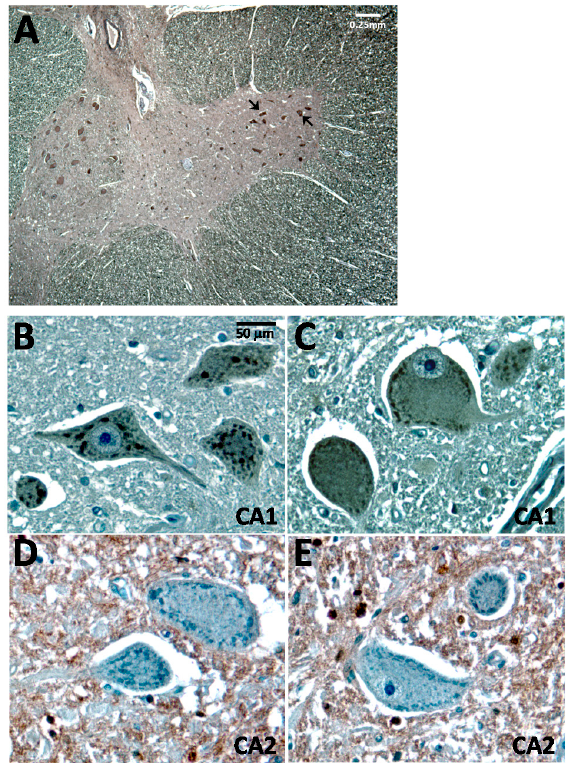
Figure 1. CA1 is expressed in human spinal cord motor neurons. Images of the normal human spinal cord immune-stained with CA1 or CA2 antibody using the DAB method (brown color) counter-stained with hematoxylin (blue color). The G α CA1 (1:500) and HRP-Rb α CA2 (1:500) antibodies were used for this experiment. ( A ) A low magnification image of the ventral horn of spinal cord stained with the CA1 antibody. Two representative motor neurons are indicated by arrows. The white scale bar indicates 0.25 mm; ( B , C ) Higher magnification of spinal cord images stained with the CA1 antibody; ( D , E ) Higher magnification of spinal cord images stained with the CA2 antibody; The black scale bar indicates 50 μ m for ( B – E ).